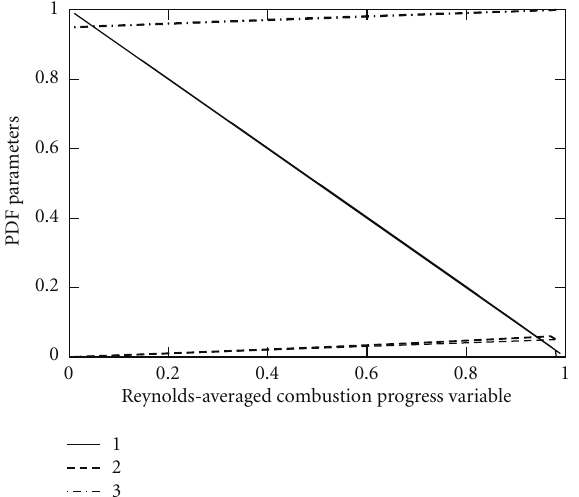
Figure 11: Dependencies of the parameters of the R-2 δ (thin curves) and 2 δ (bold curves) PDFs on the Reynolds-averaged combustion progress variable, calculated for g = 0 . 9 and F = 1 . 0. (1) α , (2) c 1 , (3) c 2 .